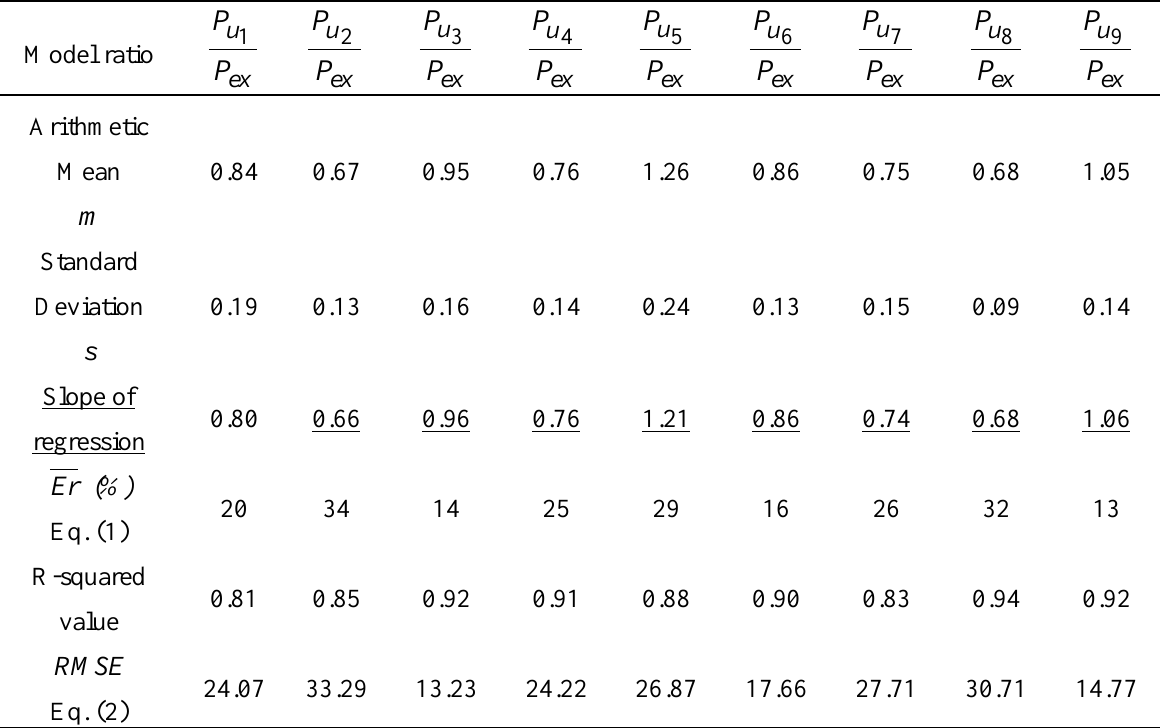
Table 2. Statistical parameters of the patch load resistance